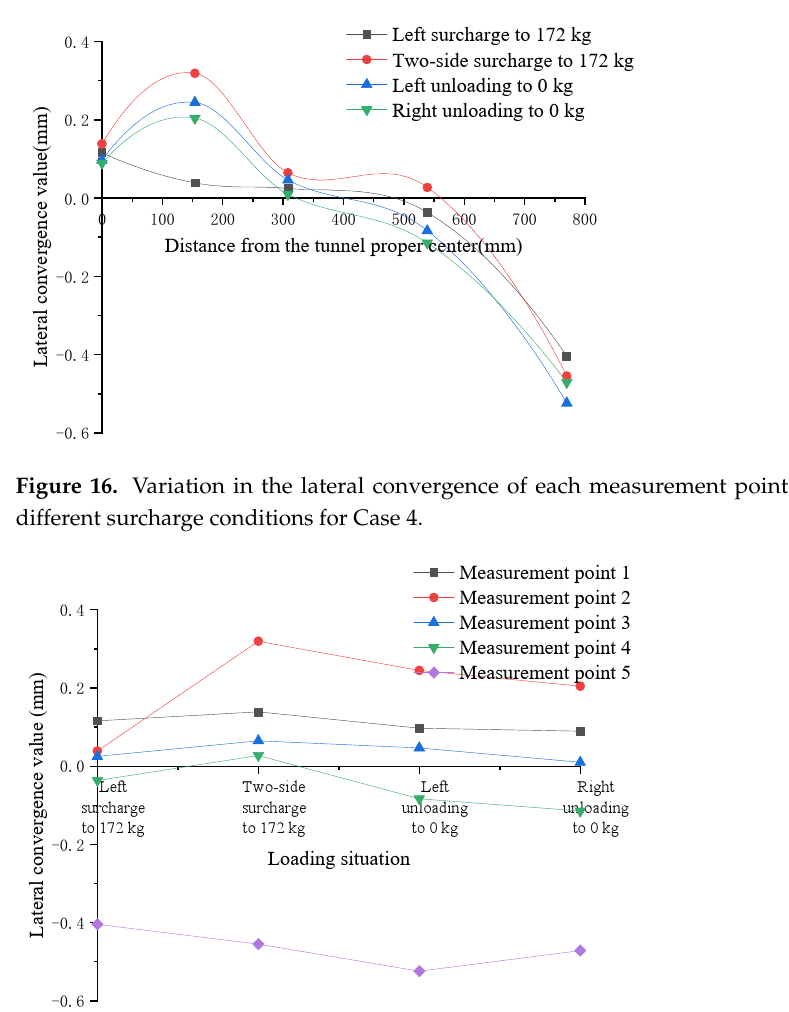
Figure 17. Variation in the lateral convergence of the tunnel under different surcharges for each measurement point in Case 4.